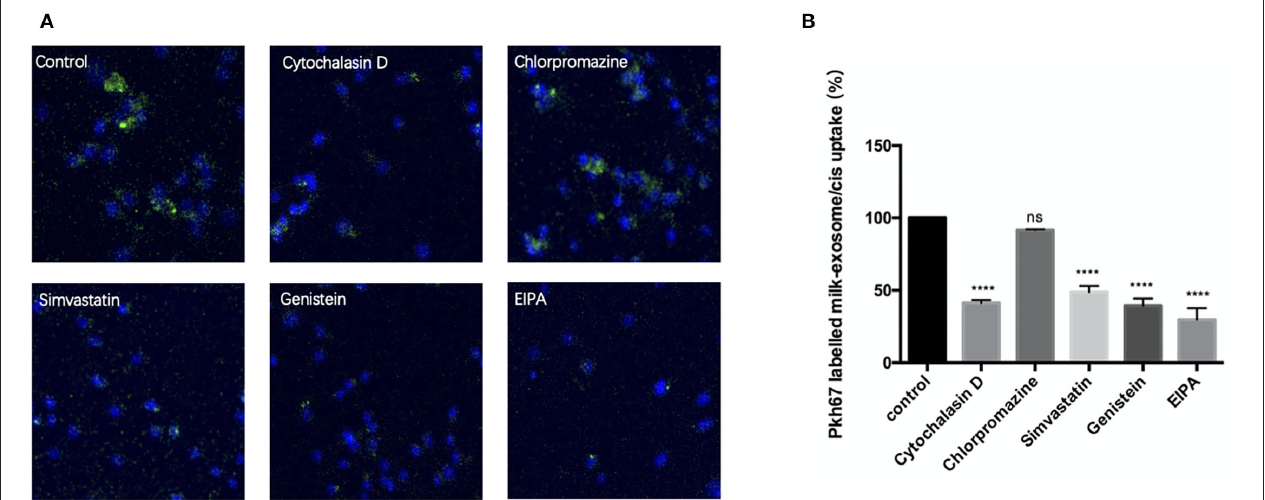
FIGURE 6 | Analysis of the influence of endocytosis pathway inhibitors upon inhibiting pkh67 labeled milk-exosome/cis internalization via confocal microscopy. (A) Pkh67 labeled milk-exosome/cis uptake by A2780CP cells pretreated with endocytosis pathway inhibitors cytochalasin D (actin polymerization inhibitor), chlorpromazine (clathrin-dependent endocytosis inhibitor), genistein (clathrin-independent endocytosis inhibitor), simvastatin (cholesterol synthesis inhibitor) and EIPA (macropinocytosis inhibitor). (B) Quantification of pkh67 labeled milk-exosome/cis (green spots) uptake by A2780CP cells (blue fluorescence DAPI labeled nuclei) pretreated with endocytosis pathway inhibitors by confocal microscopy. Values represent mean ± S.E.M. ****, P < 0.0001. ns, no significance.